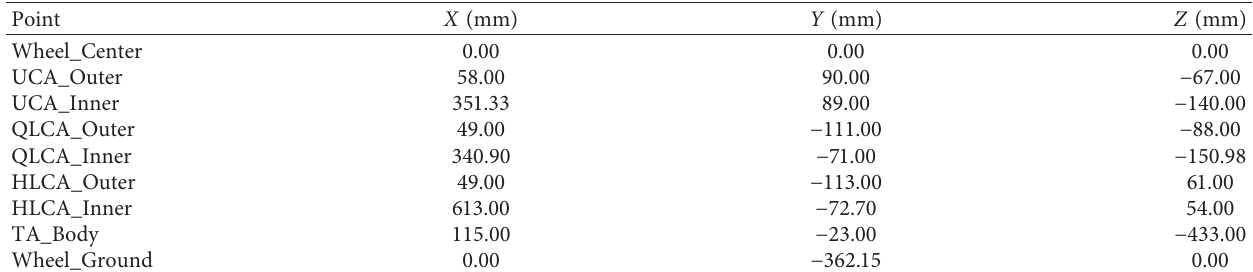
Table 3: Optimized suspension positioning point parameters.